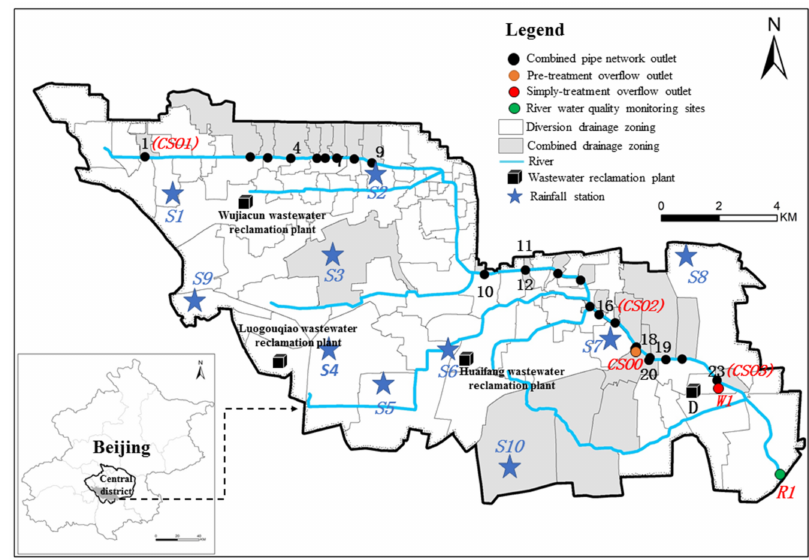
Figure 1. Location and monitoring points of Liangshui River